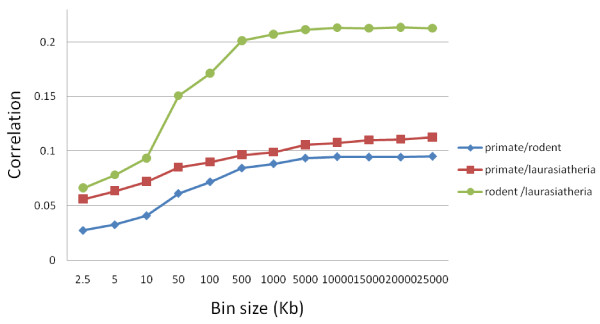
Scaling behavior of rate correlations. To determine the importance of regional effects on the correlations, we normalized the substitution rate of each repeat with respect to the average substitution rate in its local neighborhood, varying the bin size and hence the scope of the neighborhood. We then recalculated the correlations as a function of bin size. While the correlations are stable for bin sizes larger than 500 kb, they decrease in all three comparisons as the bin size becomes smaller. These results indicate that much of the correlations are due to regional effects on the scale of ~10–500 kb.